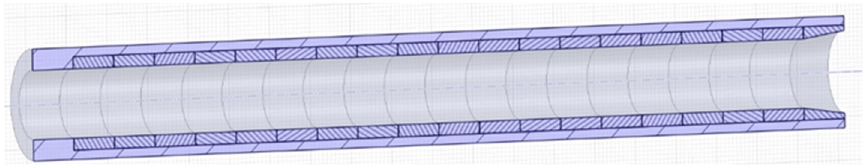
Figure 10. Tubular test section with cylindrical EUROFER samples located inside a 316 L pipe.